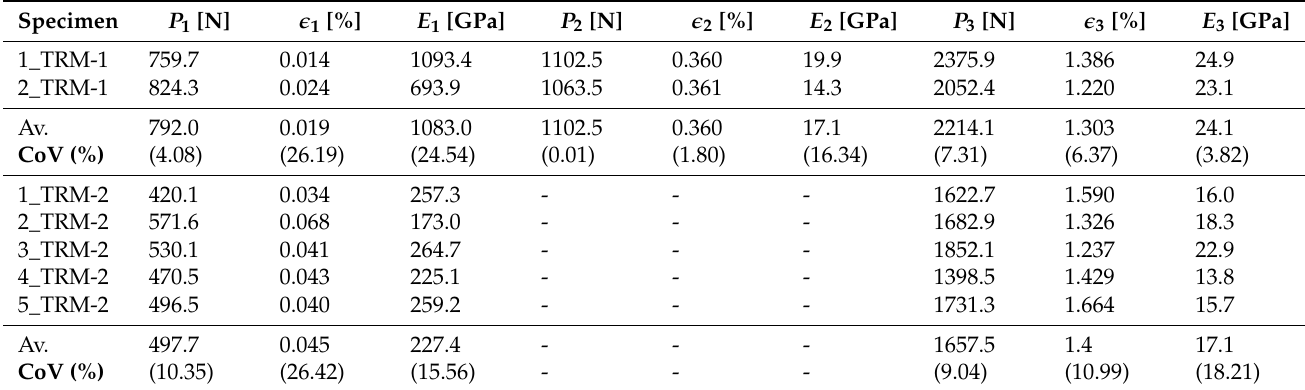
Figure 5. Tensile test on specimens TRM-2: ( a ) tensile load-axial strain curve; ( b ) failure mode. The experimental results of tensile tests on glass-TRM systems are summarized in Table 2. The load values P 1 , P 2 and P 3 are measured by the load cell of the machine while the corresponding axial strains (cid:101) 1 , (cid:101) 2 , (cid:101) 3 are calculated through the measurements of the knife transducers along the central part of the strips. The slope values E 1 , E 2 , E 3 of the three branches are calculated by referring the tensile stress to the fiber cross section A f , equal to 4.9 mm 2 , as indicated in the AC434.13 [12]. Table 2. Results of tensile tests on glass-TRM